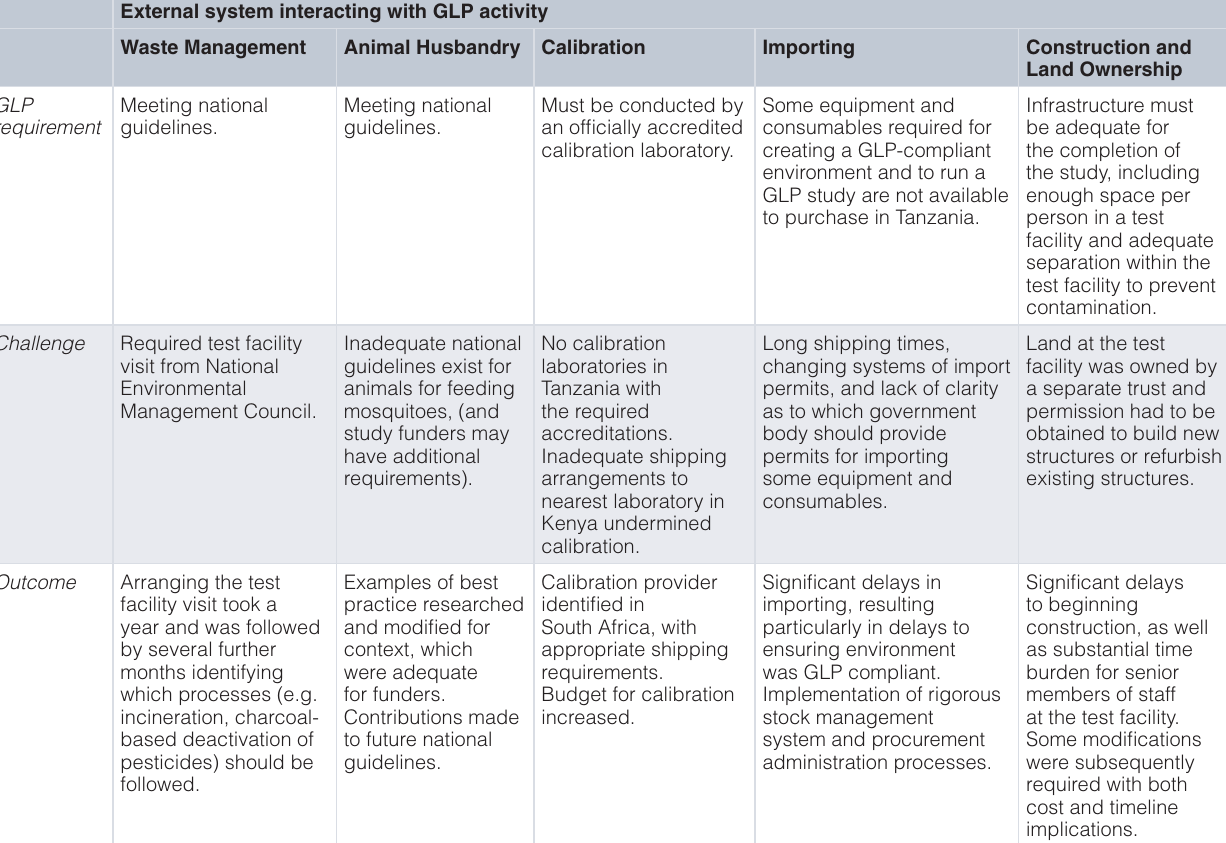
Table 3. External systems, agencies and organisations’ interactions with the test facility GLP